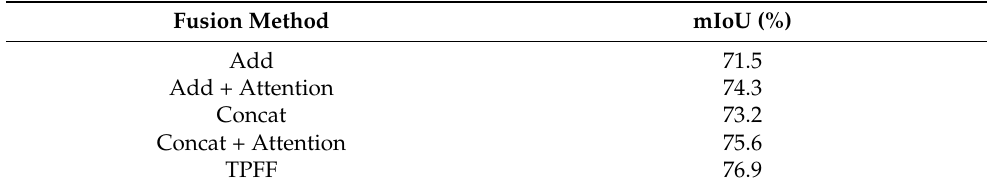
Table 2. The discussion on feature fusion